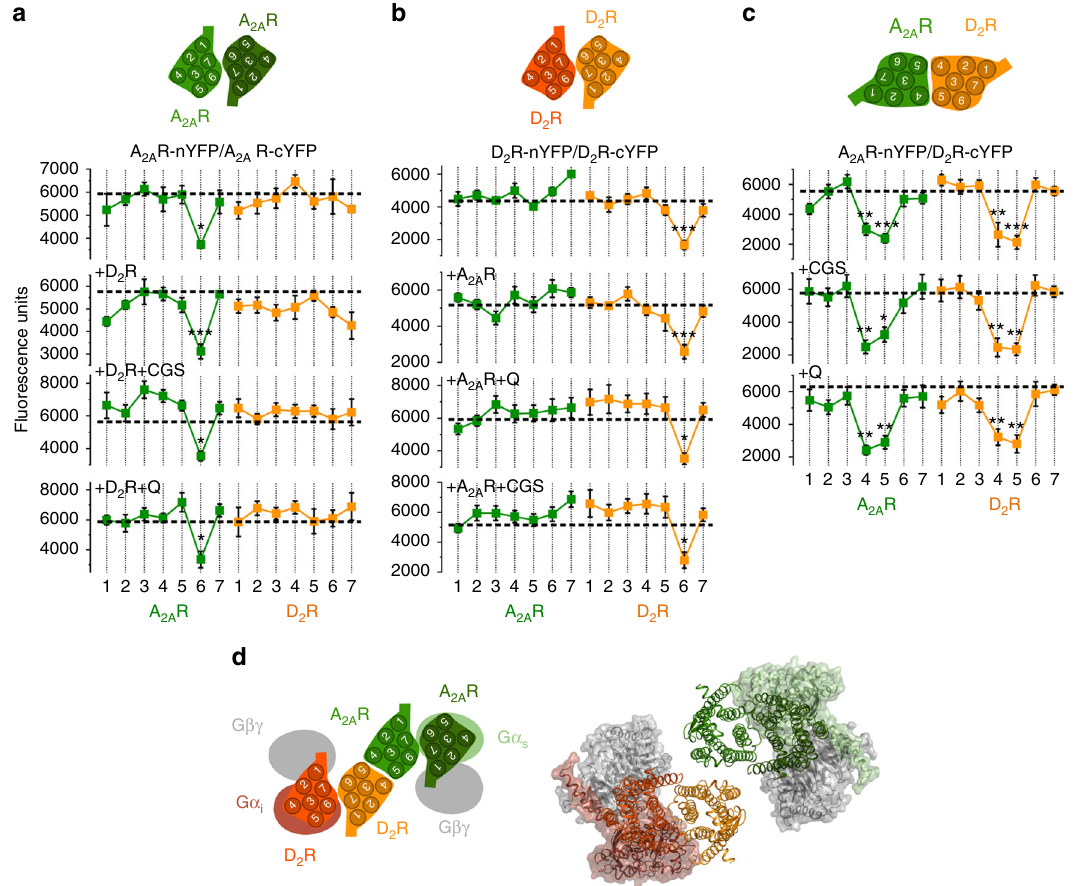
Fig. 1 Quaternary structure of A 2A R-D 2 R heterotetramer coupled to Gs and Gi proteins. a – c BiFC experiments in HEK-293T cells transfected with A 2A R- nYFP (0.5 μ g) and A 2A R-cYFP (0.5 μ g) cDNA in the absence or presence of D 2 R cDNA (0.5 μ g) ( a ), with D 2 R-nYFP (0.75 μ g) and D 2 R-cYFP (0.75 μ g) cDNA in the absence or the presence of A 2A R cDNA (0.4 μ g) ( b ) or with A 2A R-nYFP (0.6 μ g) and D 2 R-cYFP (0.6 μ g) cDNA ( c ); cells were treated for 4 h with medium (broken lines) or 4 μ M of indicated TM peptides (numbered 1 – 7) of A 2A R (green squares) or D 2 R (orange squares) before addition of medium, CGS21680 (CGS; 100 nM) or quinpirole (Q; 1 μ M); fl uorescence was detected at 530 nm and values (in means± SEM) are expressed as fl uorescence arbitrary units ( n = 8, with triplicates); *, **, and *** represent signi fi cantly lower values as compared to control values ( p < 0.05, p < 0.01 and p < 0.001, respectively; one-way ANOVA followed by Dunnett ’ s multiple comparison tests). d Computational model of the A 2A R-D 2 R heterotetramer built using the experimental interfaces predicted in panels ( a – c ) (TMs 4/5 for heterodimerization and TM 6 for homodimerization) with Gs and Gi binding to the external protomers; schematic slice-representation (left) and the constructed molecular model (right; with the same color code as the schematic slice- representation), viewed from the extracellular